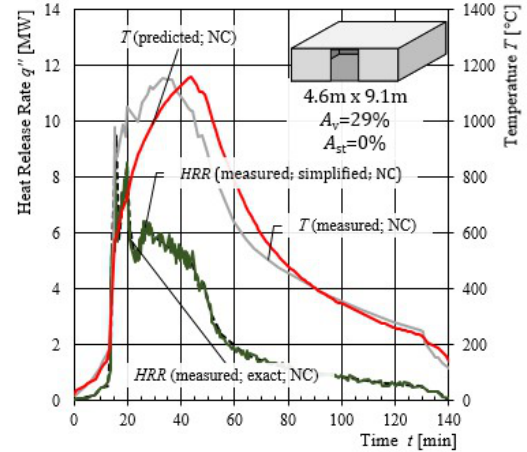
Figure 13: Predicted and measured temperatures for the HRR in baseline experiment II